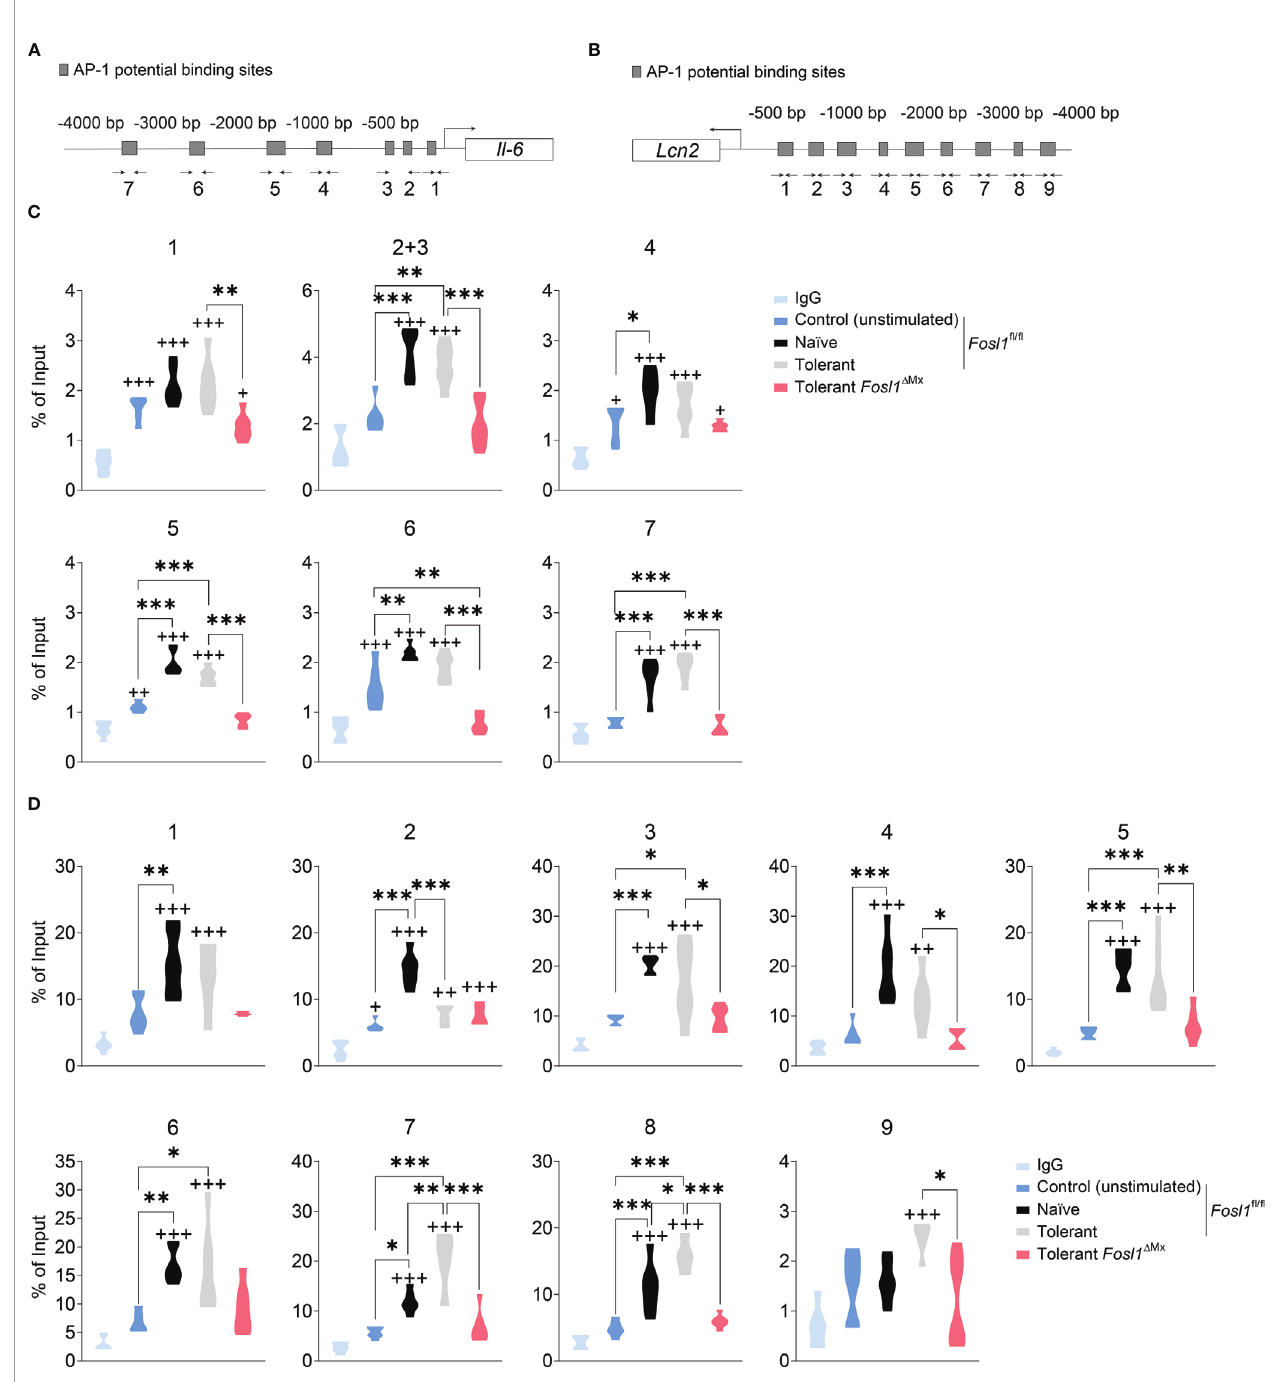
FIGURE 4 | FRA-1 binds stronger to the promoter of Lcn2 after induction of endotoxin tolerance in murine BMDM. (A, B) Prediction of the AP-1 binding sites by the online tool TFBIND and the locations of the primers for each site on Il6 (A) and Lcn2 (B) promoters. (C, D) ChIP assays showing the recruitment of the endogenous FRA- 1 on the AP-1 binding sequence of Il6 (C) and Lcn2 (D) promoters after one (naïve) or two (tolerant) stimulations with LPS in bone marrow-derived macrophages isolated from Fosl1 D Mx or littermate mice. + p < 0.05; ++ p < 0.01; +++ p < 0.001 by one-way ANOVA with Sidak ’ s multiple comparisons test. + means compared to the IgG group. *p < 0.05; **p < 0.01; ***p < 0.001 by one-way ANOVA with Sidak ’ s multiple comparisons